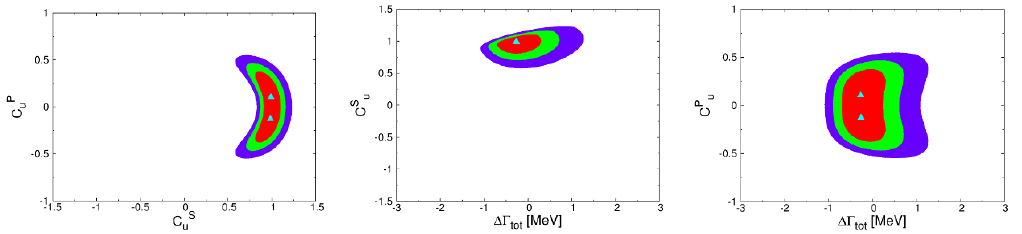
Figure 15 . CPVN3 : the con(cid:12)dence-level regions of the (cid:12)t by varying C S color code is the same as in (cid:12)gure